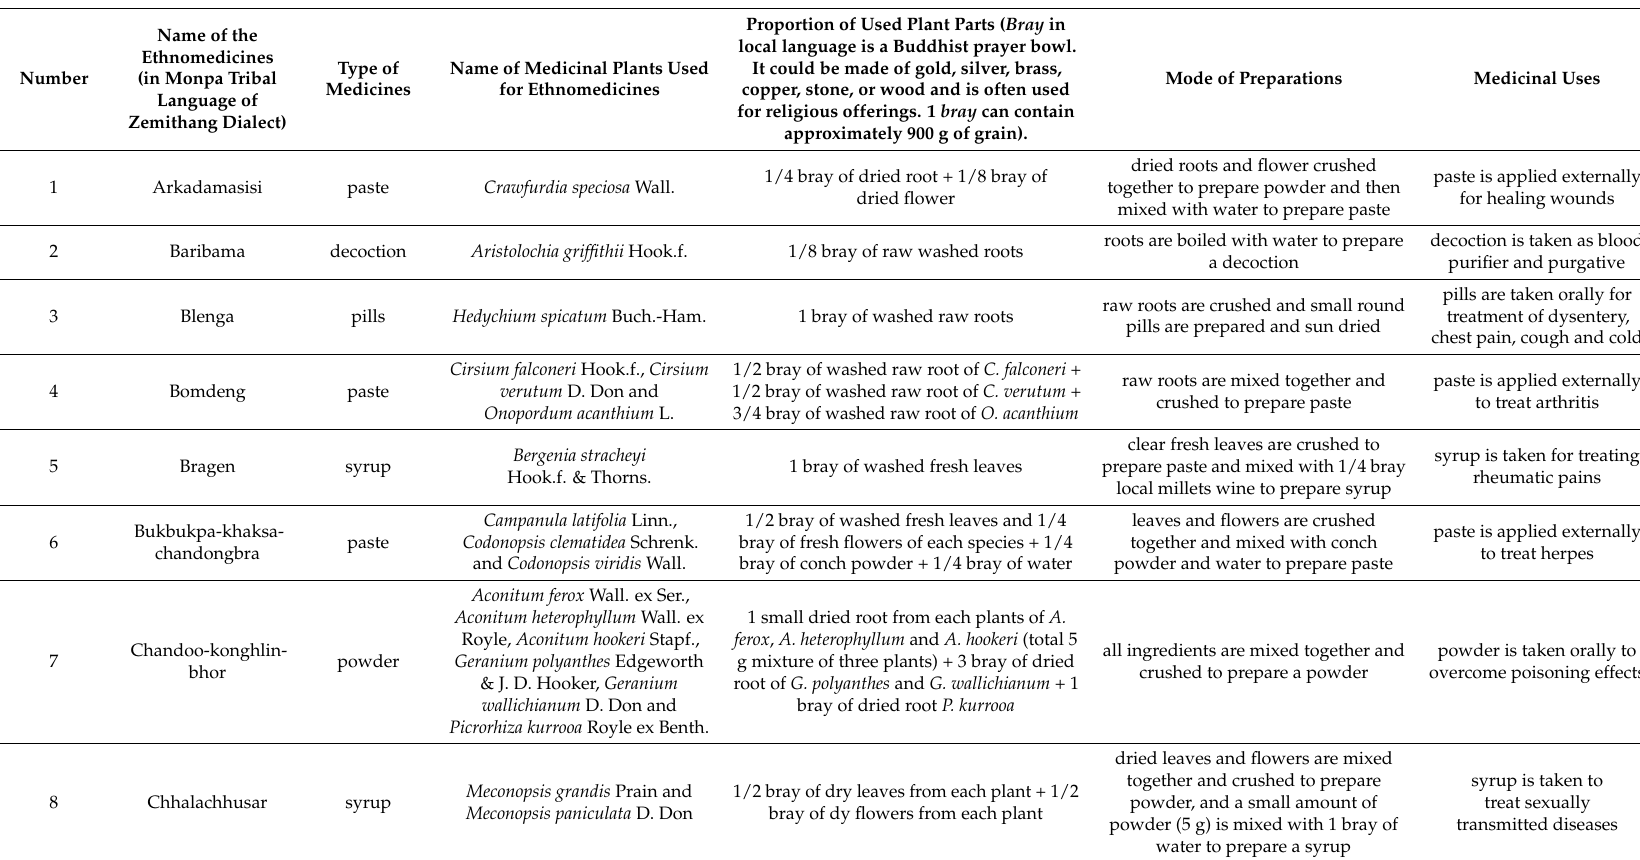
Table 1. List of 24 ethnomedicines used by the Zemithang Monpa people and the associated medicinal plants documented in this